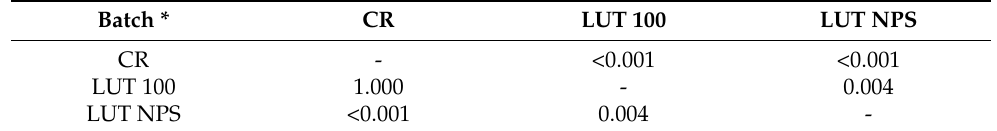
Table 3. Comparison of post hoc OXSR1 results (mg/mg protein) with regard to the batches of the Table 6. Comparison of post hoc MMP-9 results (pg/mg protein) with regard to the batches of studied